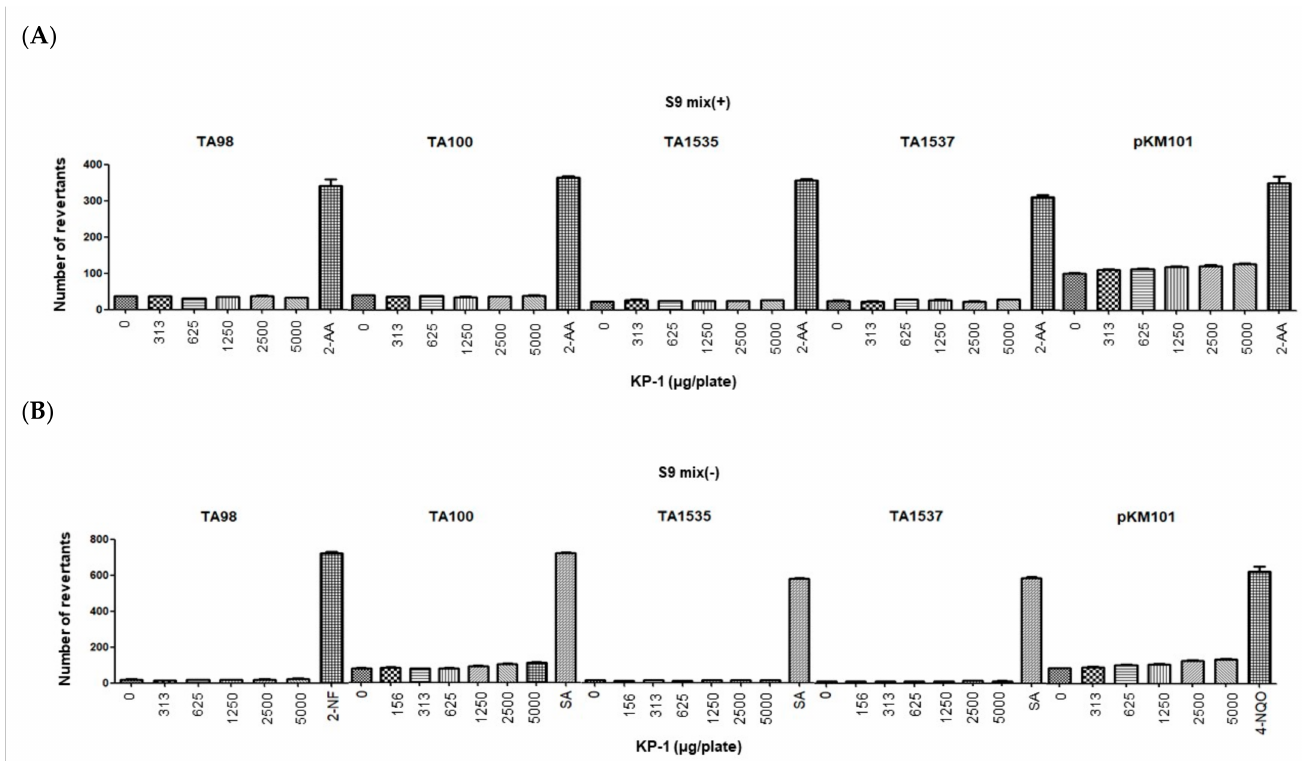
Figure 2. Effect of KP-1 on bacterial reverse mutation ( A ) with (+S9 mix) or ( B ) without (-S9 mix) the metabolic activation of Salmonella tryphiurium (TA98, TA100, TA1535, TA1537) and Escherichia coli (pKM101). A positive bacterial reverse mutation was induced by the positive control. 2-AA, 2-Amonoanthracene; 2-NF, 2-Nitrofluorene; SA, sodium azide; 4-NQO, 4-Nitroquinoline